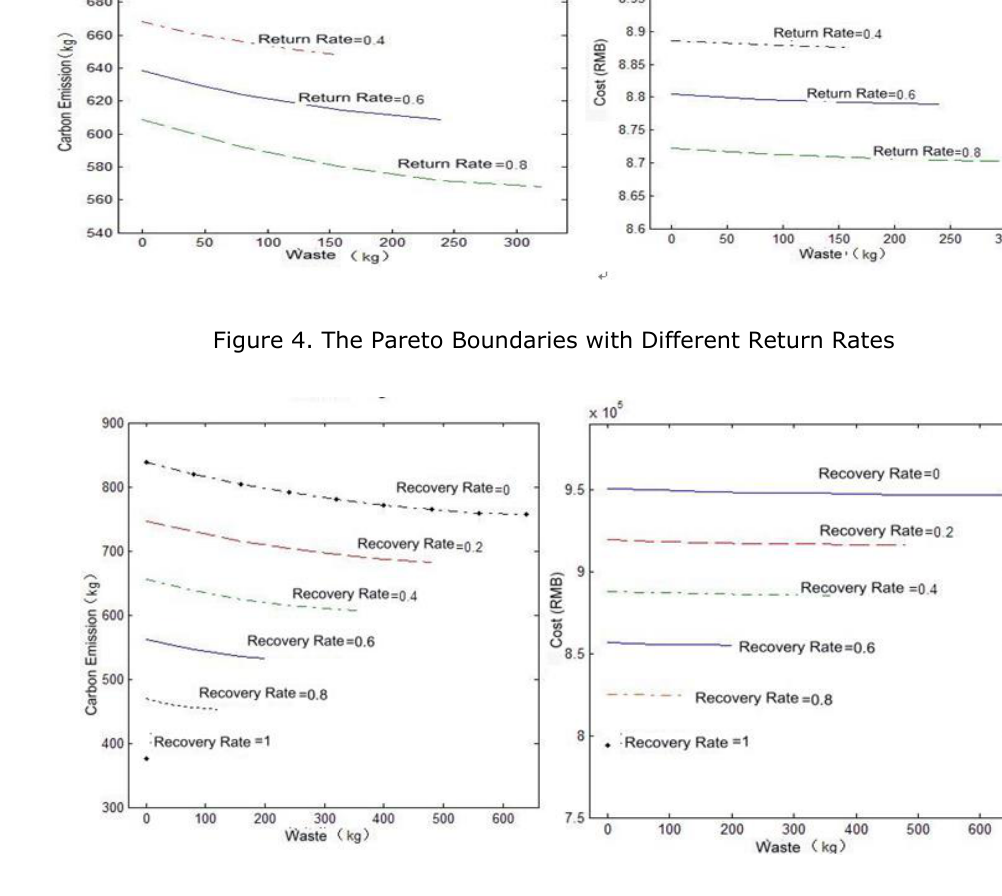
Figure 5. The Pareto Boundaries with Different Recovery